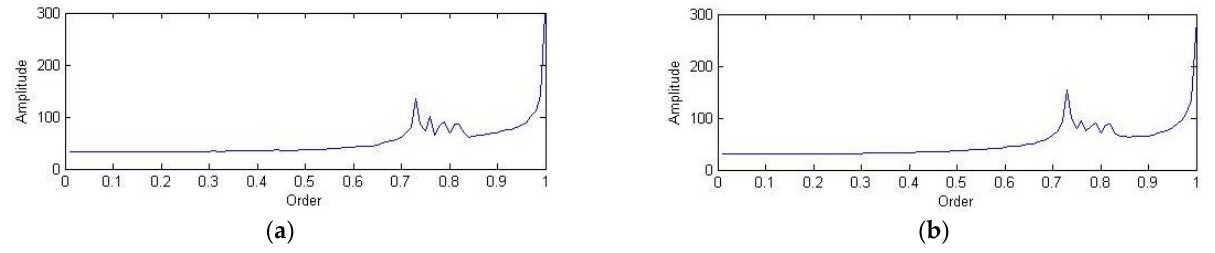
Figure 5. The maximal projection values of the 2-D FrFTs along: ( a ) the x -direction and ( b ) the y -direction, while the fractional order at the other direction is fixed as one. The intersection orders of maxima between ( a , b ) can be determined.